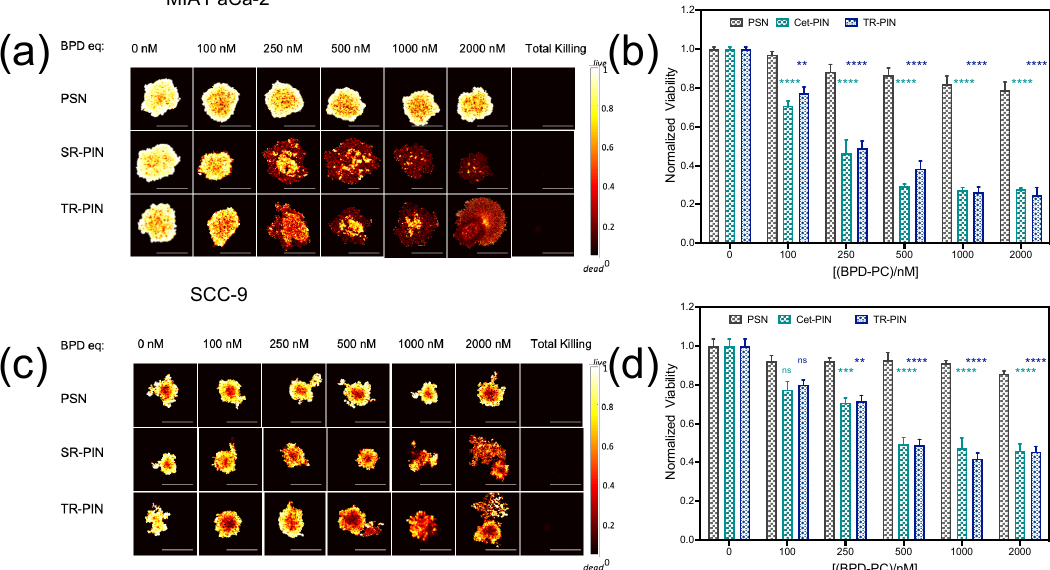
Figure 7. NIR light-mediated photodynamic treatment of 3D monocultures of MIA PaCa-2 and SCC-9 cells. Viability heatmap images of ( a ) 3D MIA-PaCa-2 and (c) SCC9 nodules following photodynamic therapy (PDT) with increasing concentrations of BPD-PC equivalent in untargeted-PSNs, Cet-targeted PINs (Cet-PINs), and triple-receptor-targeted PINs (TR-PINs) (690 nm, 40 J / cm 2 at 150 mW / cm 2 ). The comprehensive image analysis procedure for structurally complex organotypic cultures (CALYPSO) image analysis framework was used for quantitation of normalized viability following PDT ( b , d ). (mean ± S.E.M.; n = 8–12; one-way ANOVA with a Tukey post-test; **** = p ≤ 0.0001; *** = p ≤ 0.001; ** = p ≤